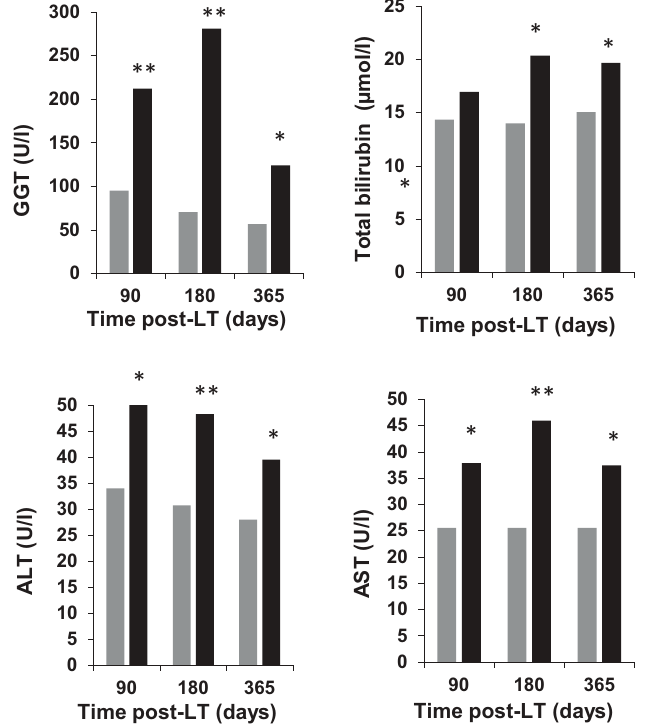
Figure 2. Evaluation of three, six, and twelve months post-LT laboratory variables in late mortality. Bars represent patients who survived more than five years (gray) and those who did not (black). Median values are shown. * p <0.05; ** p ≤ 0.001. GGT, gamma glutamyl transpeptidase; ALT, aspartate aminotransferase; AST, alanine aminotransferase; TBI, total